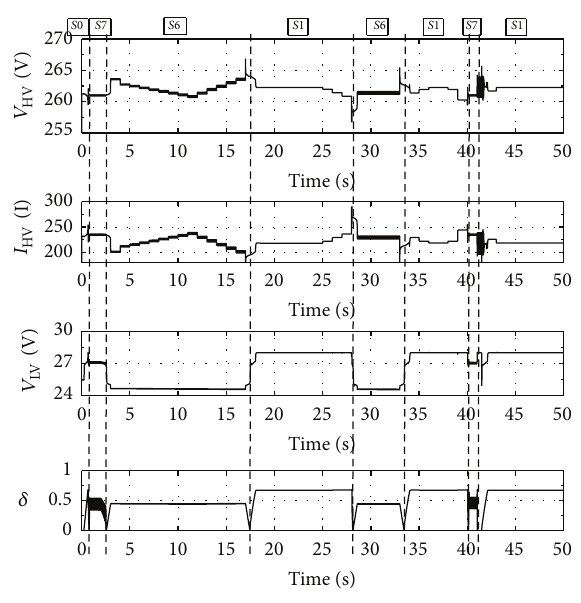
Figure 21: Buffer mode test